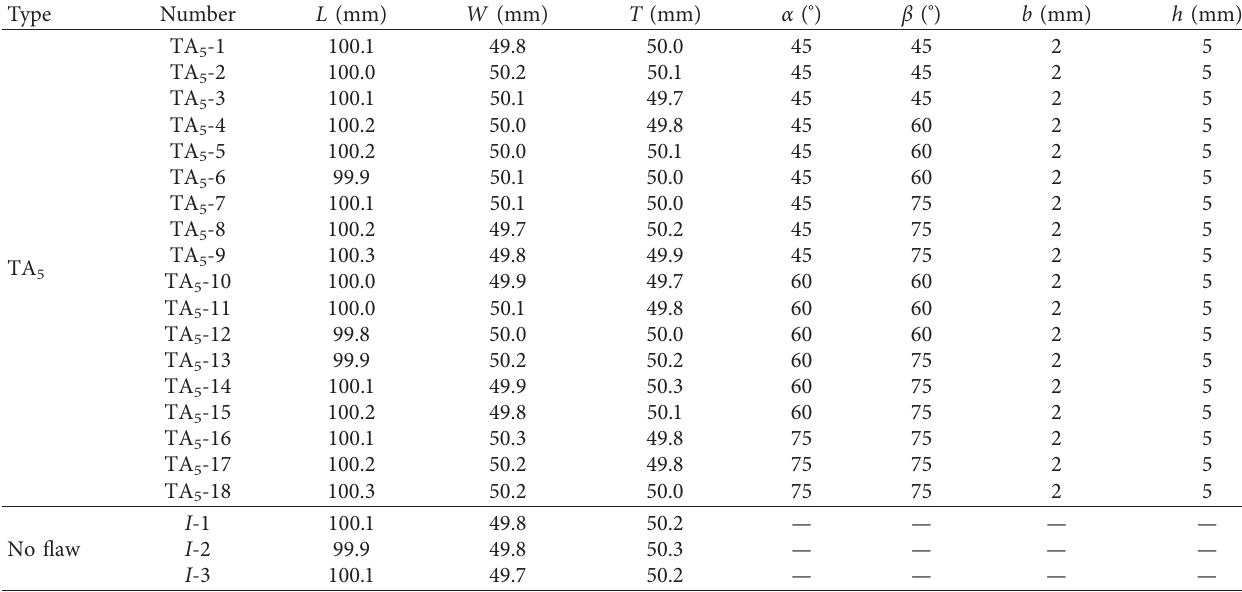
Table 1: Tested sample geometries containing two prefabricated flaws under uniaxial compression. Type